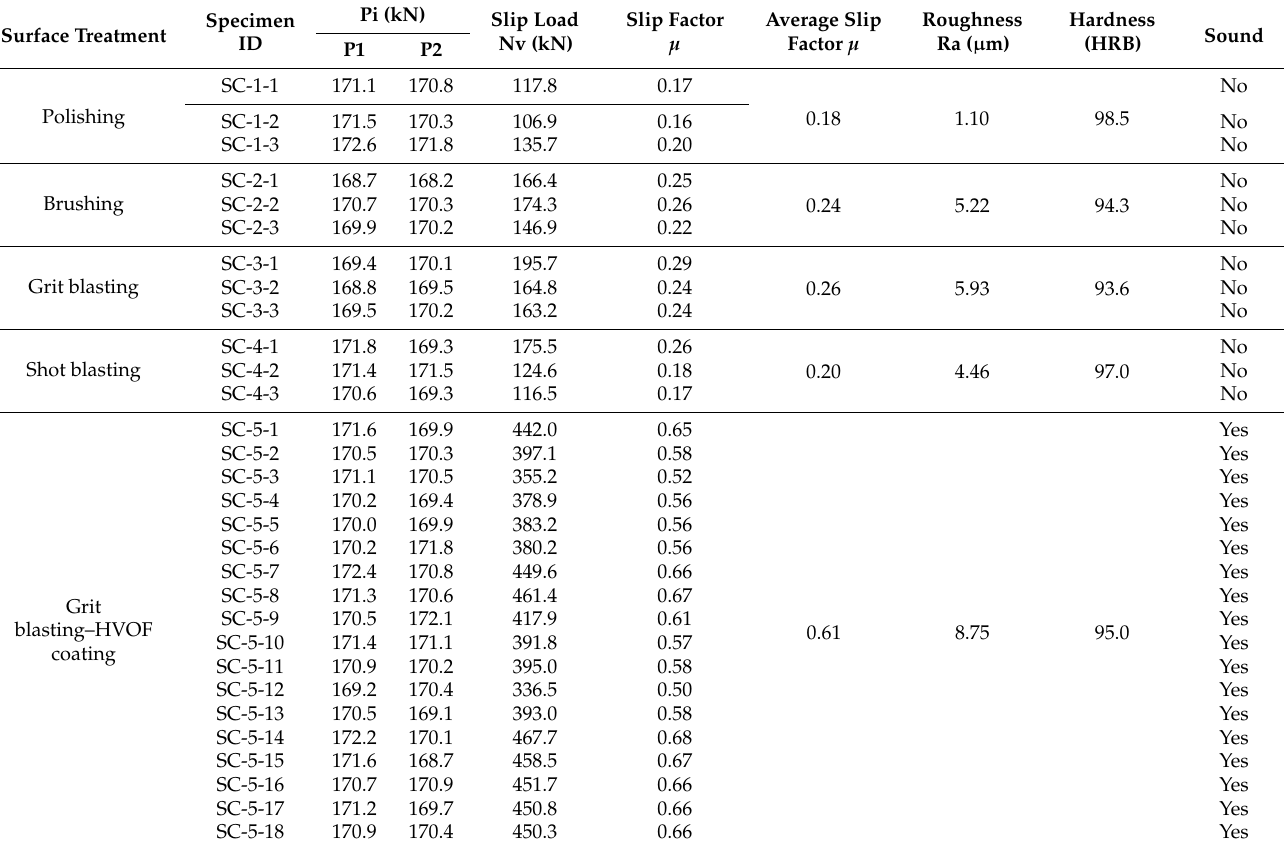
Table 2. Slip factor test